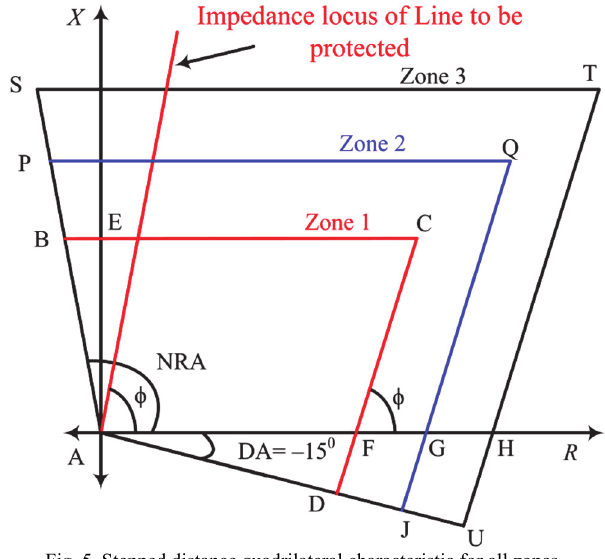
Fig. 5. Stepped distance quadrilateral characteristic for all